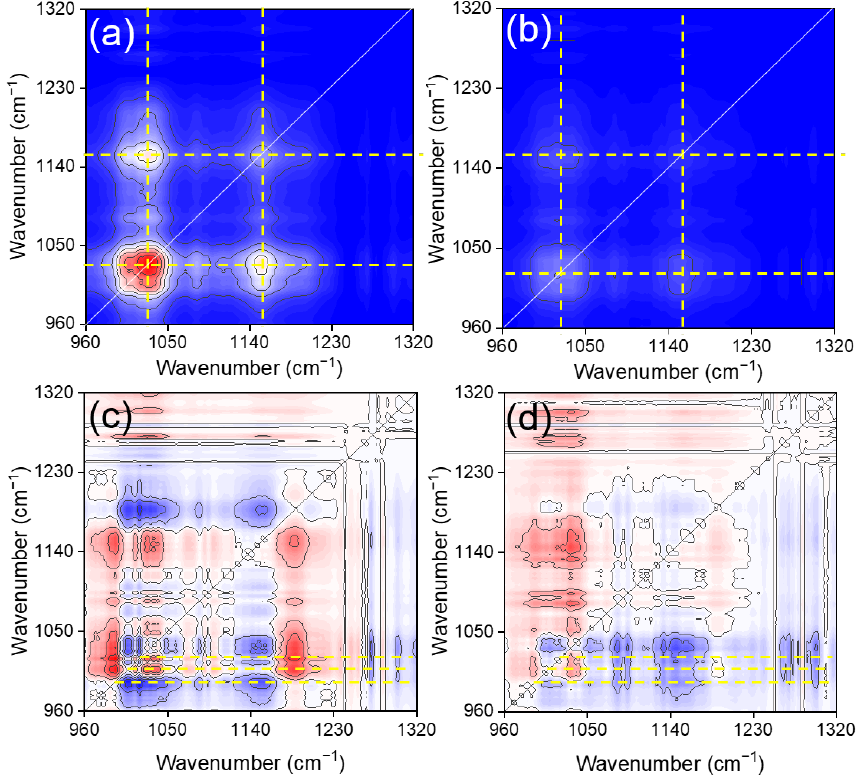
Figure 3. 2DSM and 2DAM for the Coum/SBE-β-CD inclusion complex (( a ) and ( c ), respectively), and corresponding physical mixture (( b ) and ( d ), respectively), in the 960–1320 cm −1 wavenumber range. In the case of 2DSMs, positive cross-correlation intensities ( Φ(𝜈 1 , 𝜈 2 ) > 0 ) are marked in red, while null ones in blue ( Φ(𝜈 1 , 𝜈 2 ) = 0 ). On the other side, in 2DAMs, red, blue and white colored regions indicate positive, negative and null cross-correlation intensities, respectively. Yellow dashed lines are guide for the eyes. See text for details.